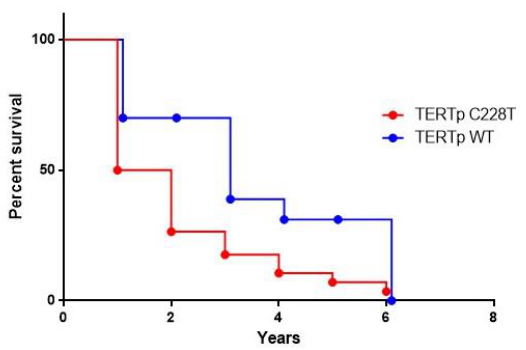
Figure 3. Survival percentages were compared using the log-rank test (Mantel–Cox). HCC cases with TERTp − 124A mutation had a reduced survival (median survival = 18 months) compared to not-mutated cases (median survival = 36 months). ( p = 0.0159; Mantel–Haenszel hazard ratio